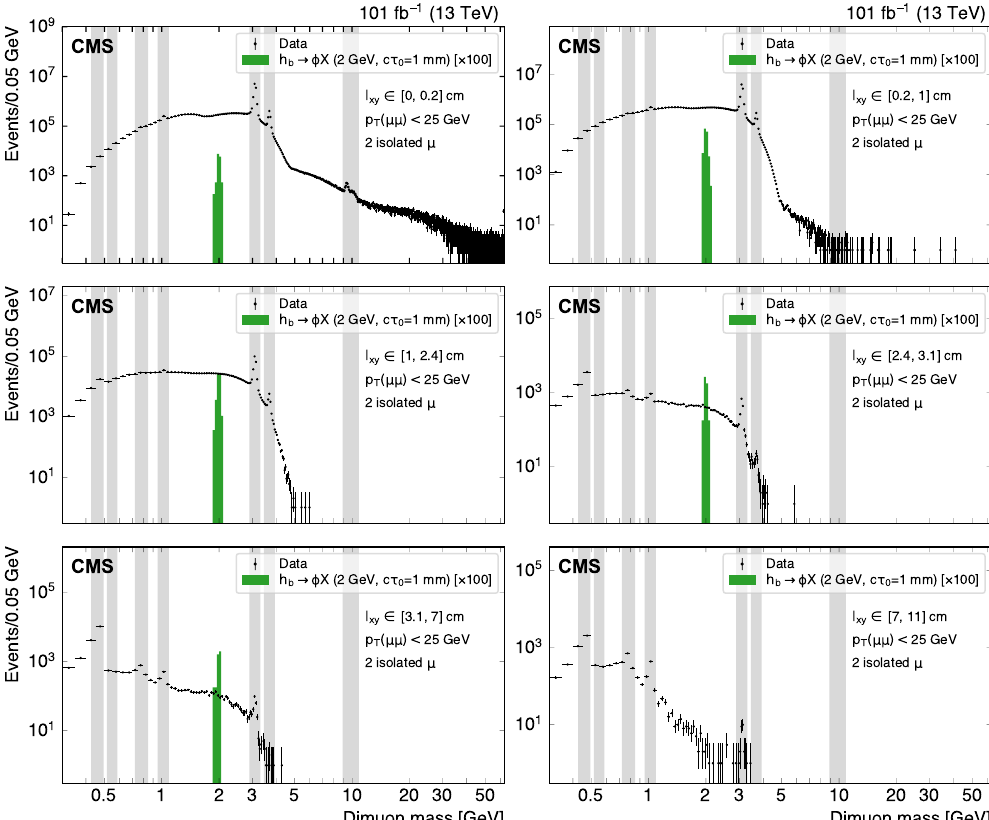
as obtained from xy < 25 GeV: (upper left) T < 2 . 4 cm; (middle xy < 11 . 0 xy